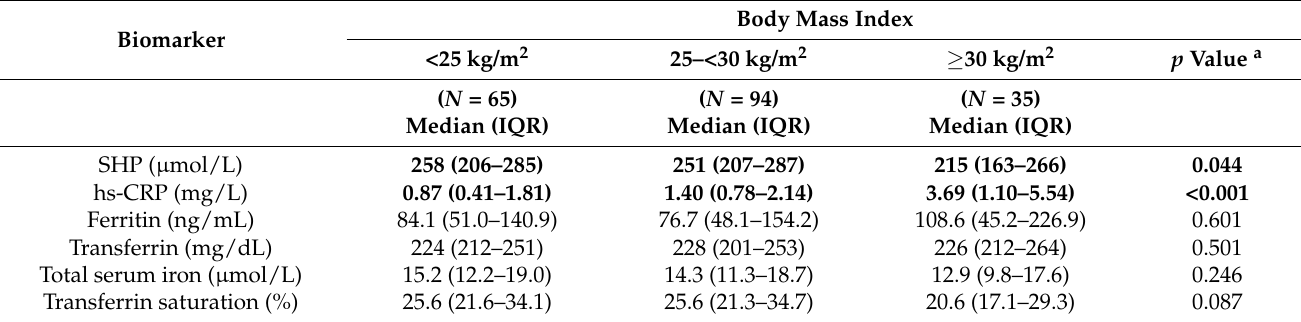
Table 3. Differences in median concentrations of biomarkers of oxidative stress, inflammation and body-iron stores according to body mass